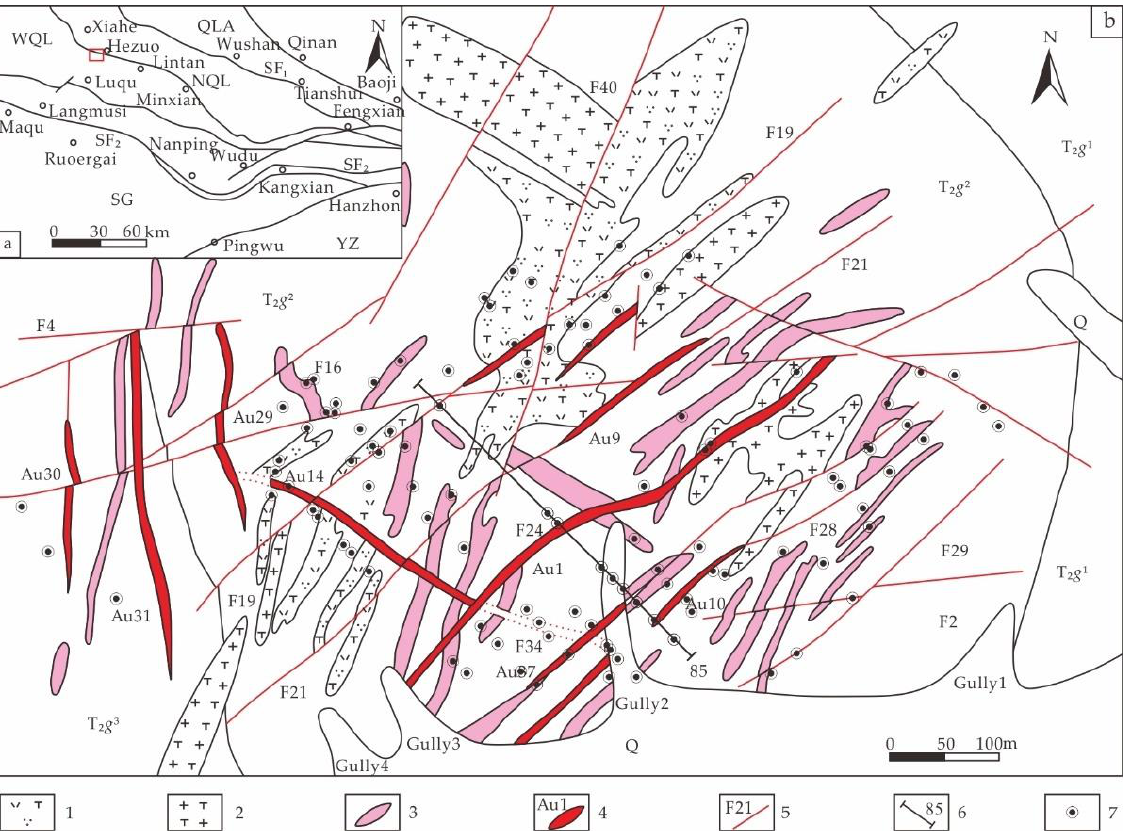
Figure 2. ( a ) Regional location of study area. QLA = Qilian tectonic belt; WQL: West Qinling tectonic belt; NQL: North Qaidam tectonic belt; SF1: Wushan – Tianshui – Shangdan suture zone; SF2: Maqu- Nanping – Lueyang suture zone; SG: Songpan – Ganzi tectonic belt; YZ: Yangtze block. ( b ) Geological map of Zaozigou gold deposit (modified from [71]). 1. Quartz diorite porphyrite; 2. Granodiorite- porphyry; 3. Plagioclase granite porphyry; 4. Gold orebody; 5. Fracture; 6. Mineral exploration line;